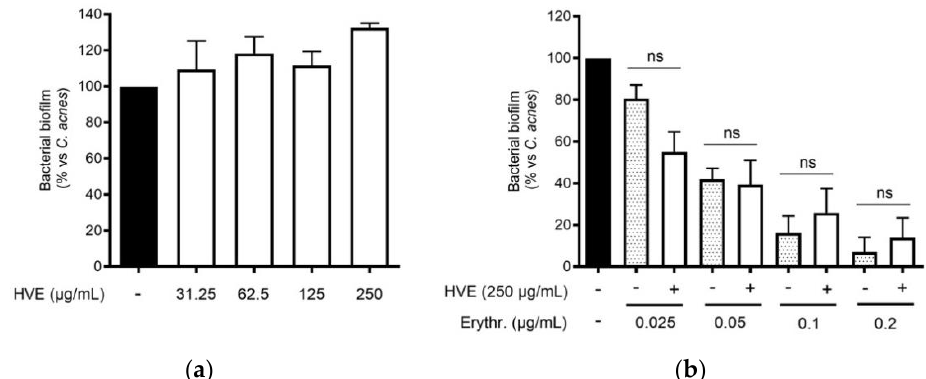
Figure 4. Effect of HVE treatment (125 –1000 μg/mL) on the biofilm formation of C. acnes (O.D. = 0.1) for 24 h. Erythromycin (0.2 μg/mL) was used as the antibiotic control ( − 90% of growth vs. control). Evaluation of HVE alone ( a ) or in co-administration, at 250 μg/mL , with erythromycin (0.025 – 0.2 μg/mL) on bacterial biofilm formation ( b ). HVE + erythromycin not significant (ns) vs. equivalent concentration of erythromycin.